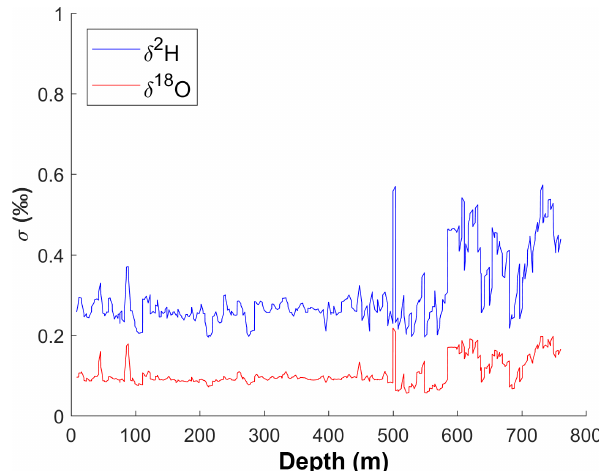
Figure 4. Allan variance error vs. depth in per mil. δ 2 H is in blue and δ 18 O is in red. The low points of the dips are the start and end of a stack, between which calibrations were carried out.